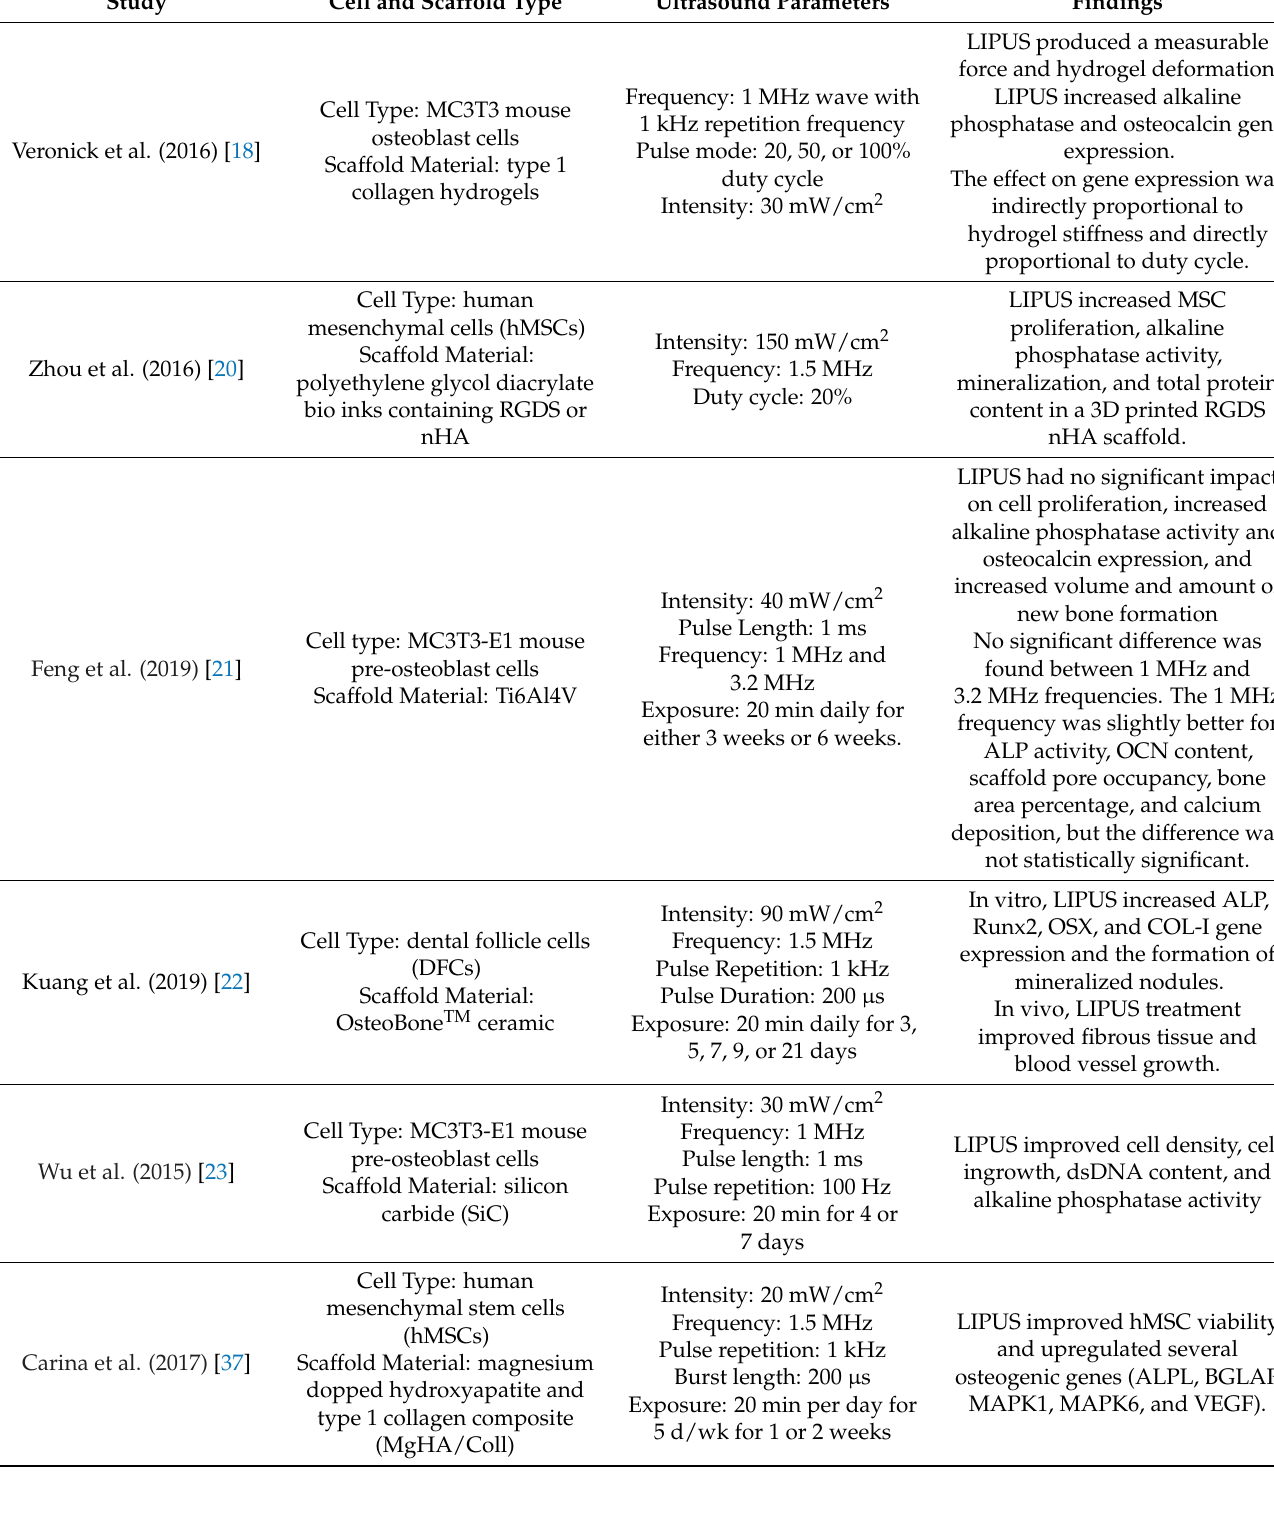
Table 2. Summary of relevant studies and results for the use of LIPUS to improve 3D bone engineering techniques.